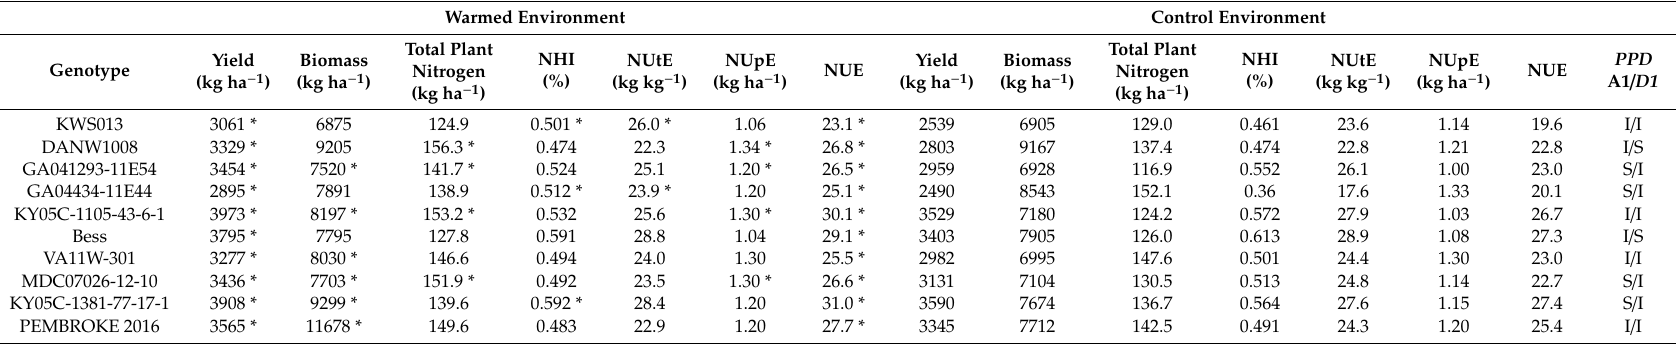
Table 7. Least squares means of lines with increased grain yields in a passively warmed environment. Agronomic and nitrogen traits † in a panel of 36 soft red winter wheat genotypes grown in control and passively warmed environments over 2 growing seasons, 2015–2016, Lexington, KY. Warmed Environment Control Environment